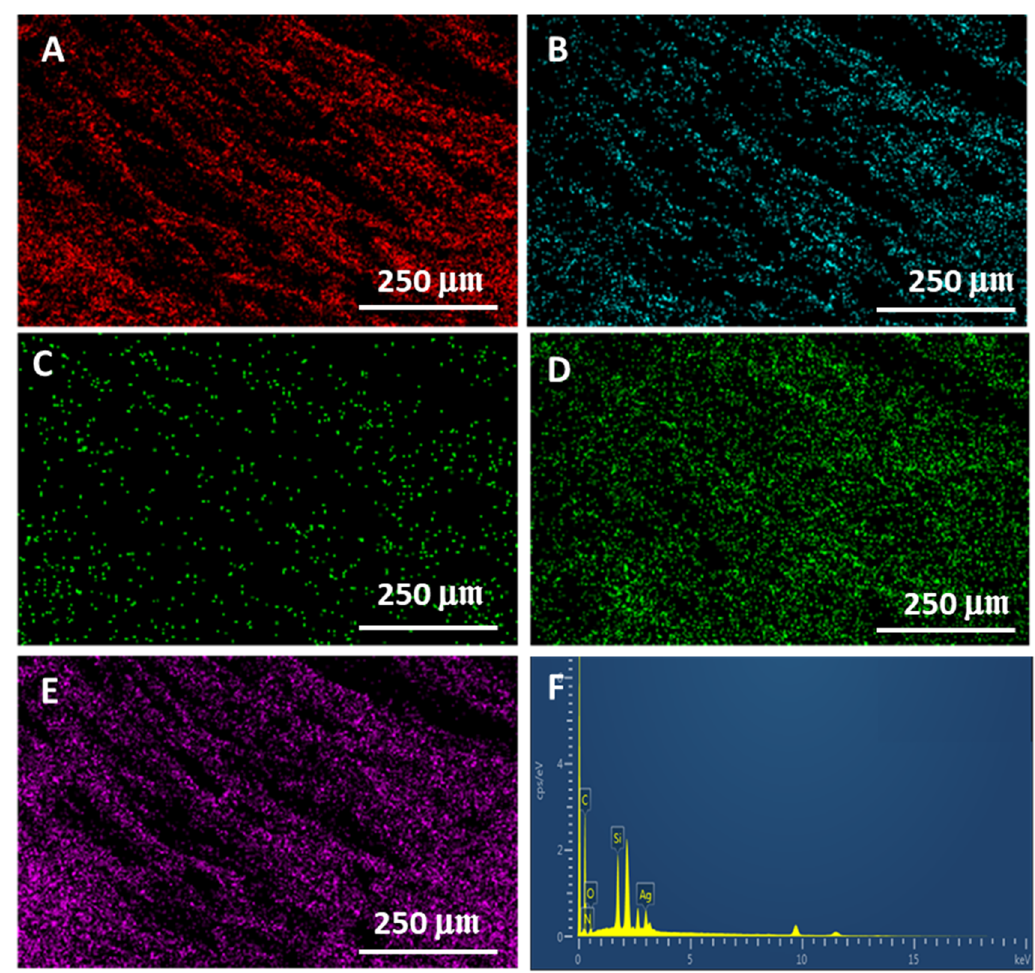
Figure 3. Elemental mapping of the C18s-Ag-DA-Cell-F ( A ) C, ( B ) O, ( C ) N, ( D ) Ag, ( E ) Si, and ( F ) EDX spectrum. Red color indicated C, cyan color O, green N and Ag, and purple color Si.